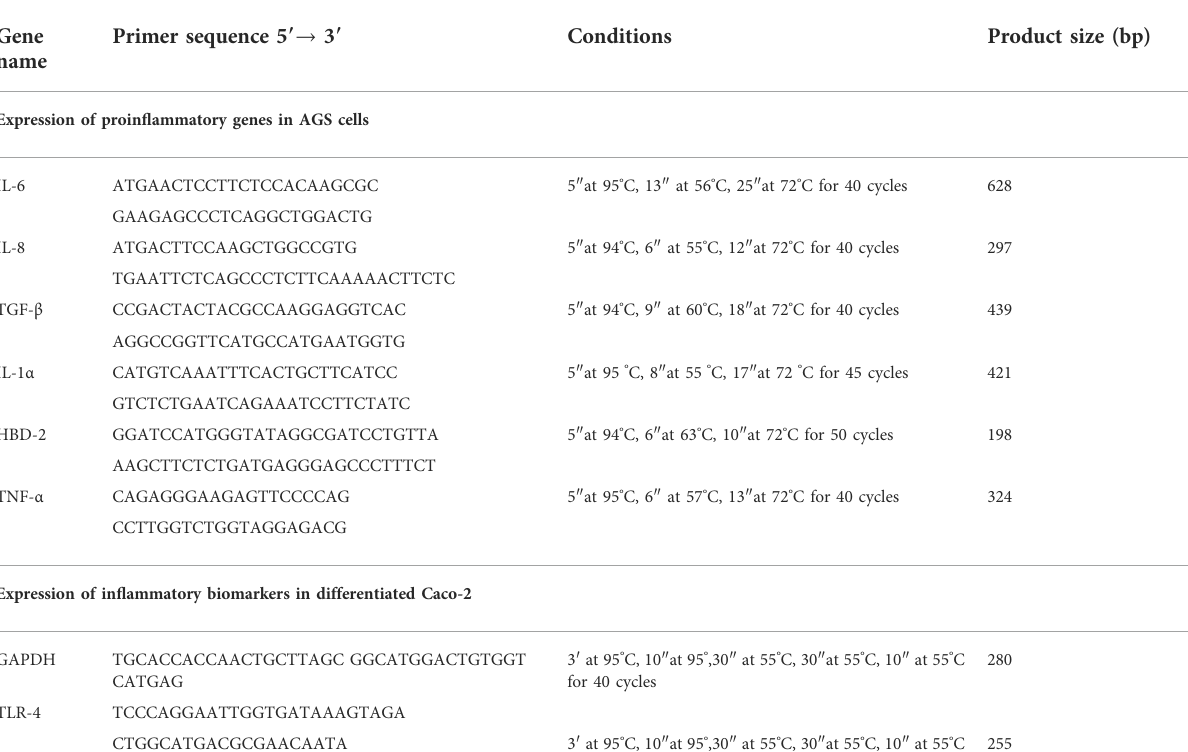
TABLE 1 Primer sequences and ampli fi cation programs used in the studies on AGS and Caco-2 cell